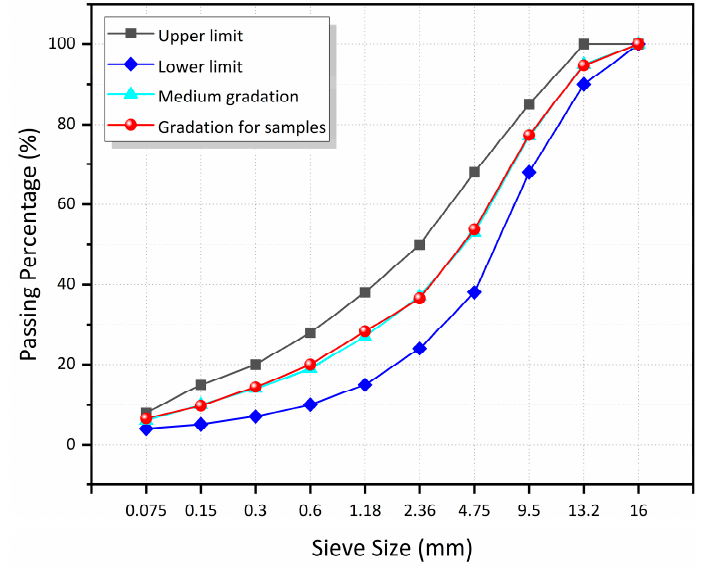
8 of 20 Figure 6. Flowchart of asphalt mastic preparation. 2.2.2. Preparation of Asphalt Mixture It is well known that large-particle-size aggregates often carry most of the traffic loads in asphalt mixtures [42]. Therefore, to avoid changing the skeleton structure, the magnetite aggregates were used to replace all limestone aggregates of small particle size (2.36 mm to 4.75 mm) by equal volume. This paper uses the dense-graded asphalt concrete with AC-13 for grade design, which is commonly used for highway pavement structures